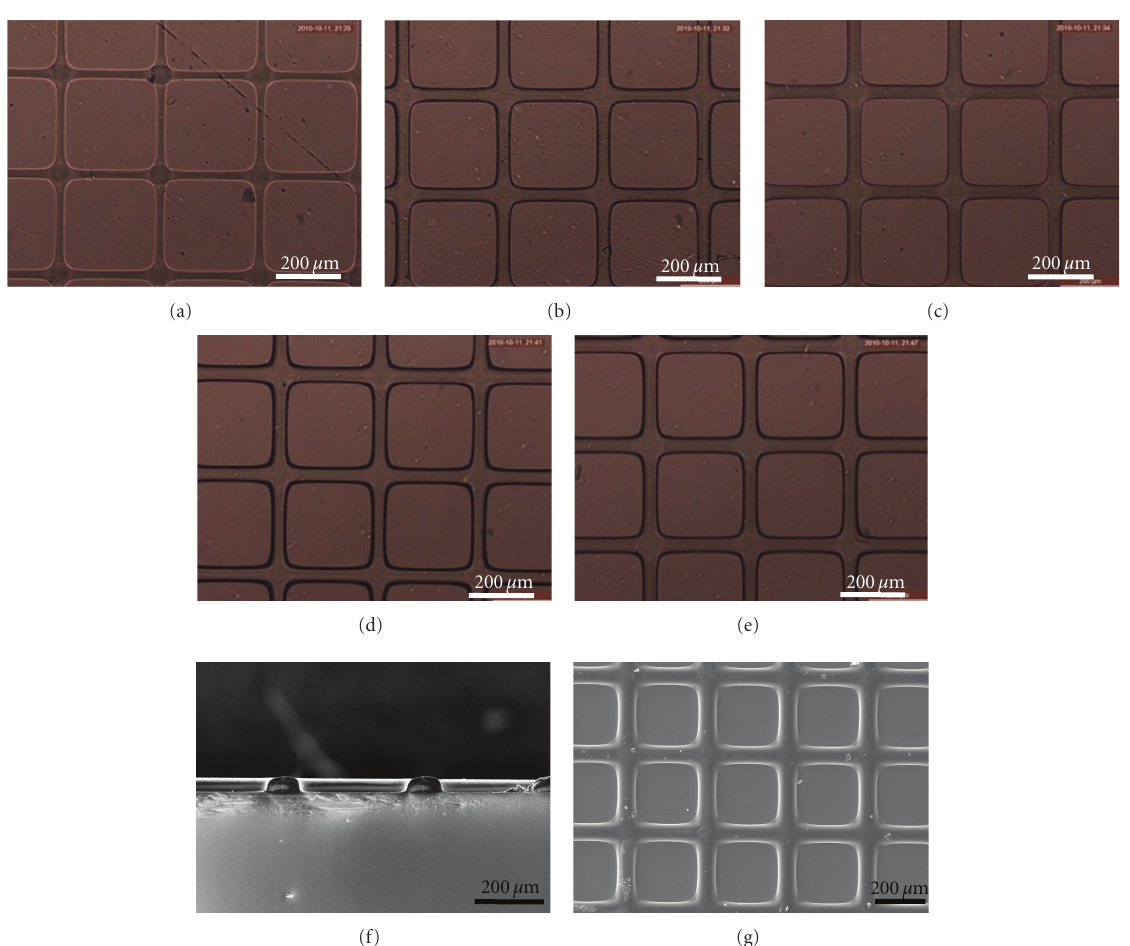
Figure 3: (a)–(e) Polymer wall surface topography of di ff erent illumination time; (f) SEM image of the cross-section of polymer wall; (g) SEM image of the surface morphology of polymer